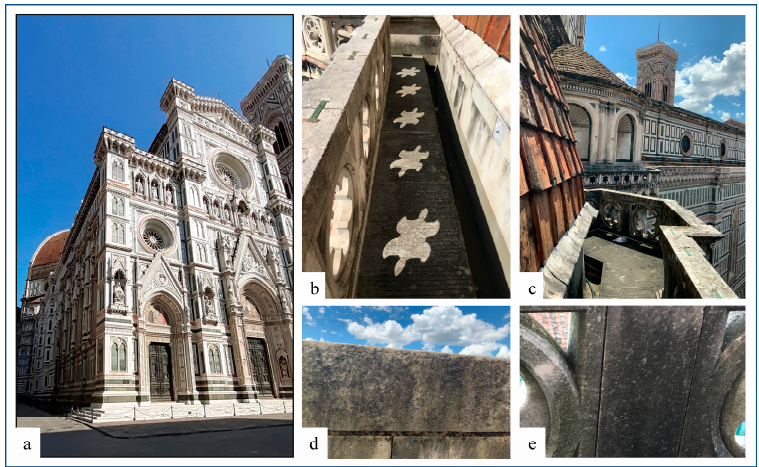
Figure 1. The Cathedral of Santa Maria del Fiore and the study sites. ( a ) The façade; ( b ) the external gallery running around the apses of the SE exposed façade; ( c ) the external gallery on the NW exposed façade; ( d ) a detail of the marble surface of the inner face of the openwork parapet of the SE exposed gallery; ( e ) a detail of the openwork parapet at the NW site showing a widespread dark